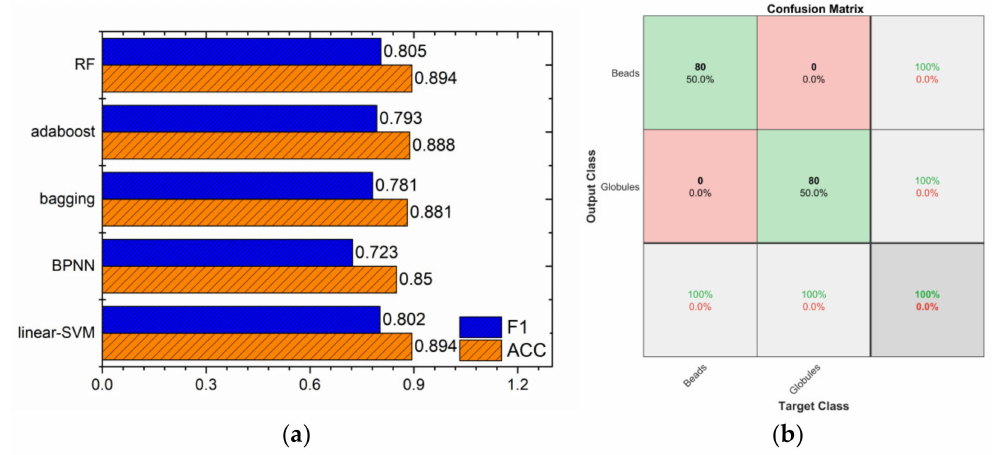
Figure 19. Classification performance comparison among machine learning methods. Figures shown in ( a , b ) are classifiers’ ACC/F1 values and confusion matrix of beads and globules of machine learning classifiers, respectively.